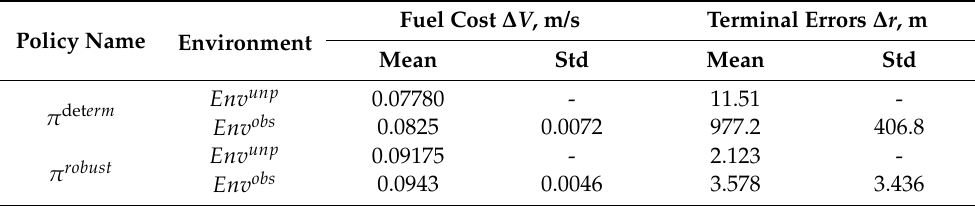
Table 7. Terminal accuracy of different